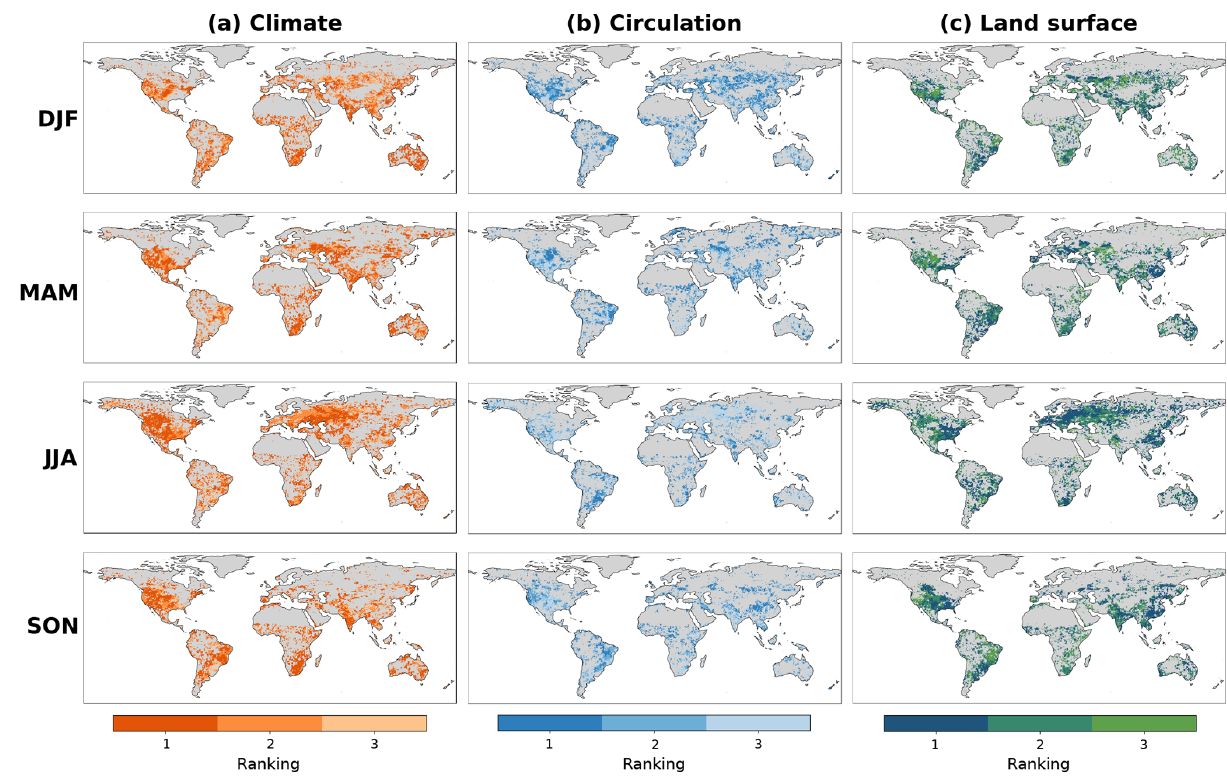
Figure 5. Ranking of groups of Earth system variables (climate, circulation, and land surface) according to the Spearman correlation coef- ficient of the most relevant variable within each group. Gray areas indicate that no variable from the group exhibits a significant correlation with temperature forecast